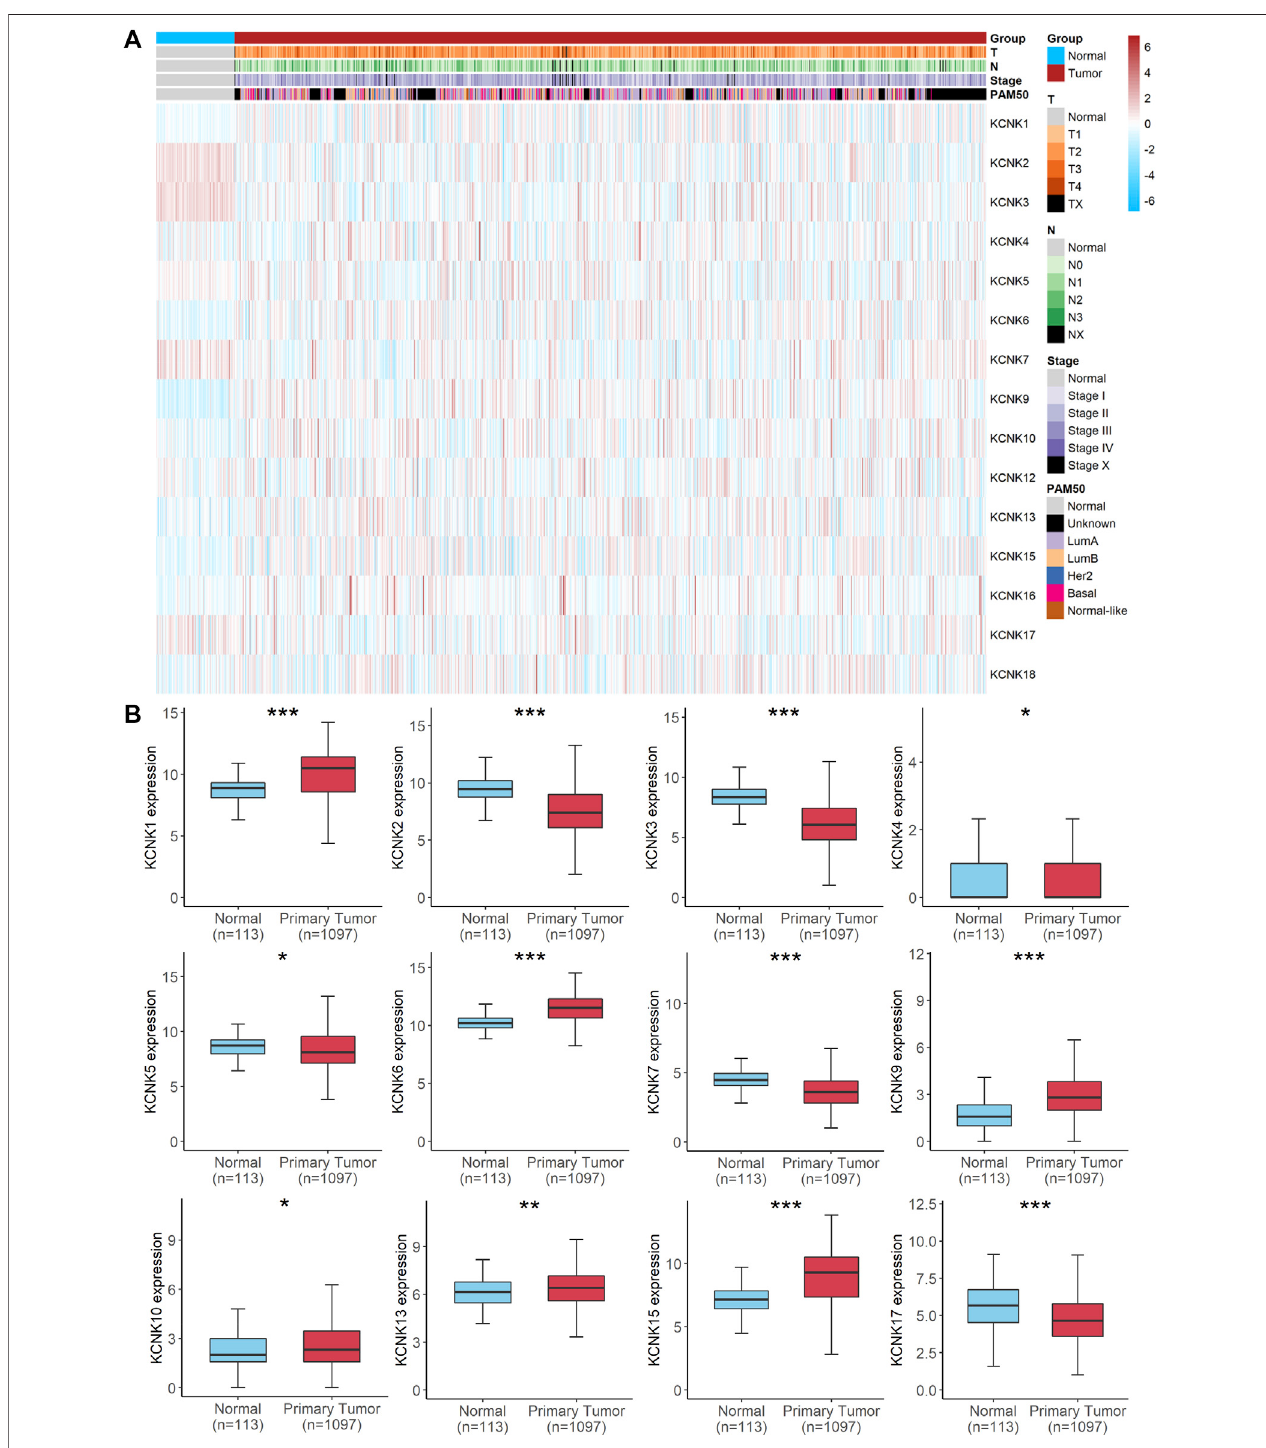
FIGURE 1 | Aberrant expression of KCNK gene family in breast cancer. (A) Heatmap of the expression of 15 KCNKs and corresponding clinical information of patients with breast cancer according to the TCGA database. (B) Boxplots of the differently expressed KCNKs in normal mammary and breast cancer tissues.